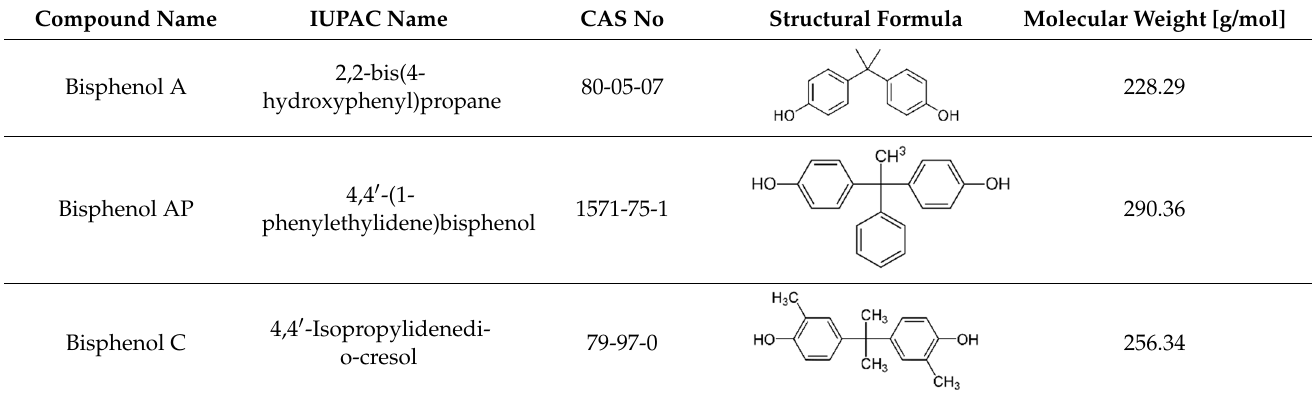
Table 1. UPAC name, CAS N°, structural formulas, the molecular mass of BPA, and its analogues BPAP and BPC.